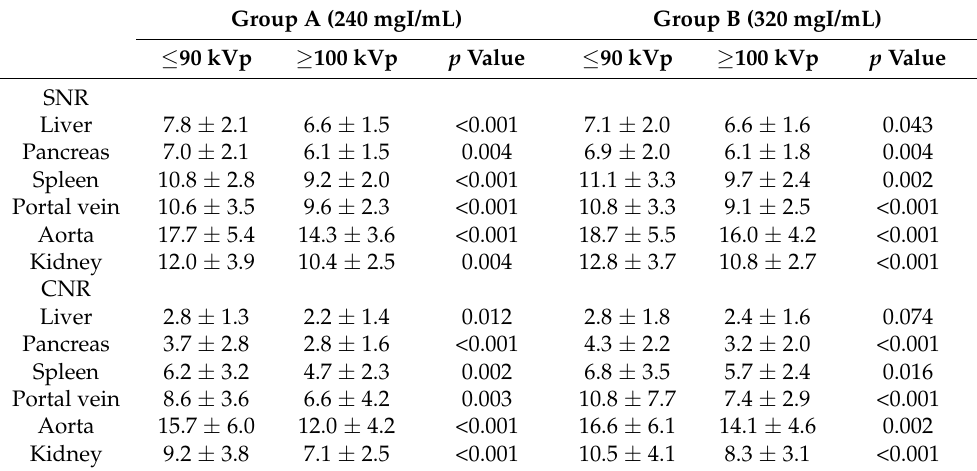
Table 5. Differences in quantitative image analysis between lower and higher tube voltage.